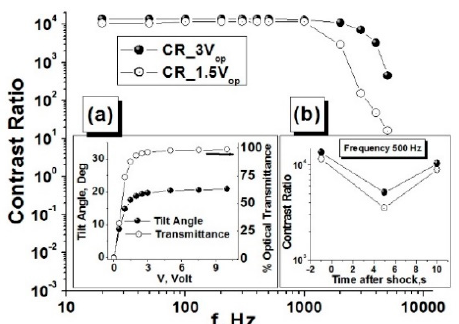
Figure 7. Dependencies of the contrast ratio on driving voltage frequency at V = 1.5 V and V = 3 V. The FLC-595 layer-thickness is 1.5 µ m, no SiO 2 layers, measurements have been carried out at T = 22 ◦ C, wavelength λ = 0.63 µ m [28,33]. Insertion left: Dependencies on voltage: measured tilt angle and the cell light transmission in comparison with transmission of empty cell placed between crossed polarizers. Insertion right: Contrast ratio dependence on time after the application of mechanical